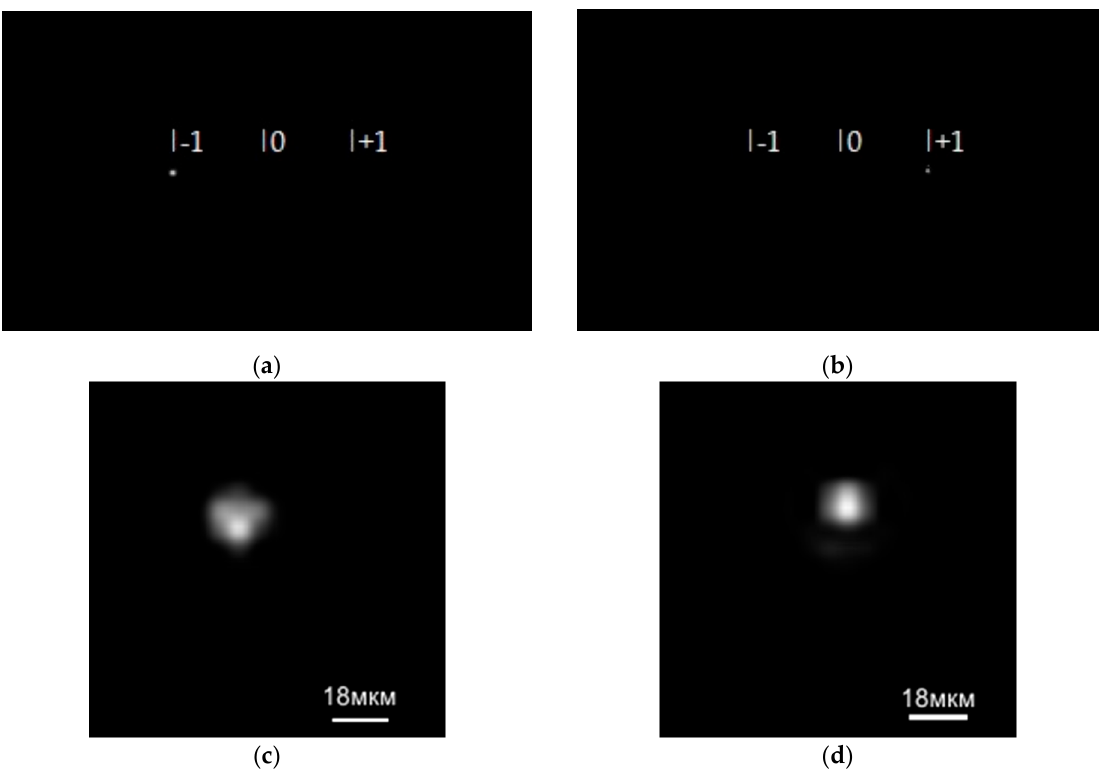
Figure 4. Diffraction orders on the imaging matrix from the SDL at wavelengths of ( a ) 455 nm, ( b ) 750 nm, and ( c , d ) their respective magnified fragments.